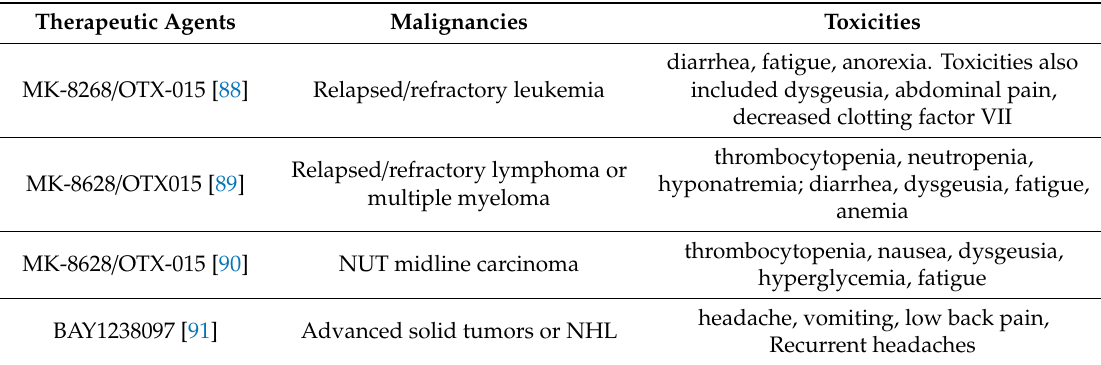
Table 2. Toxicities reported from clinical trials with BET